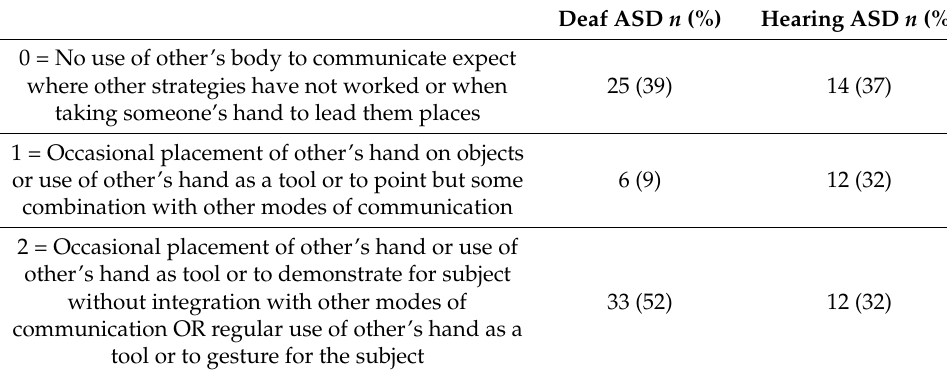
Table 7. Use of another person’s body to